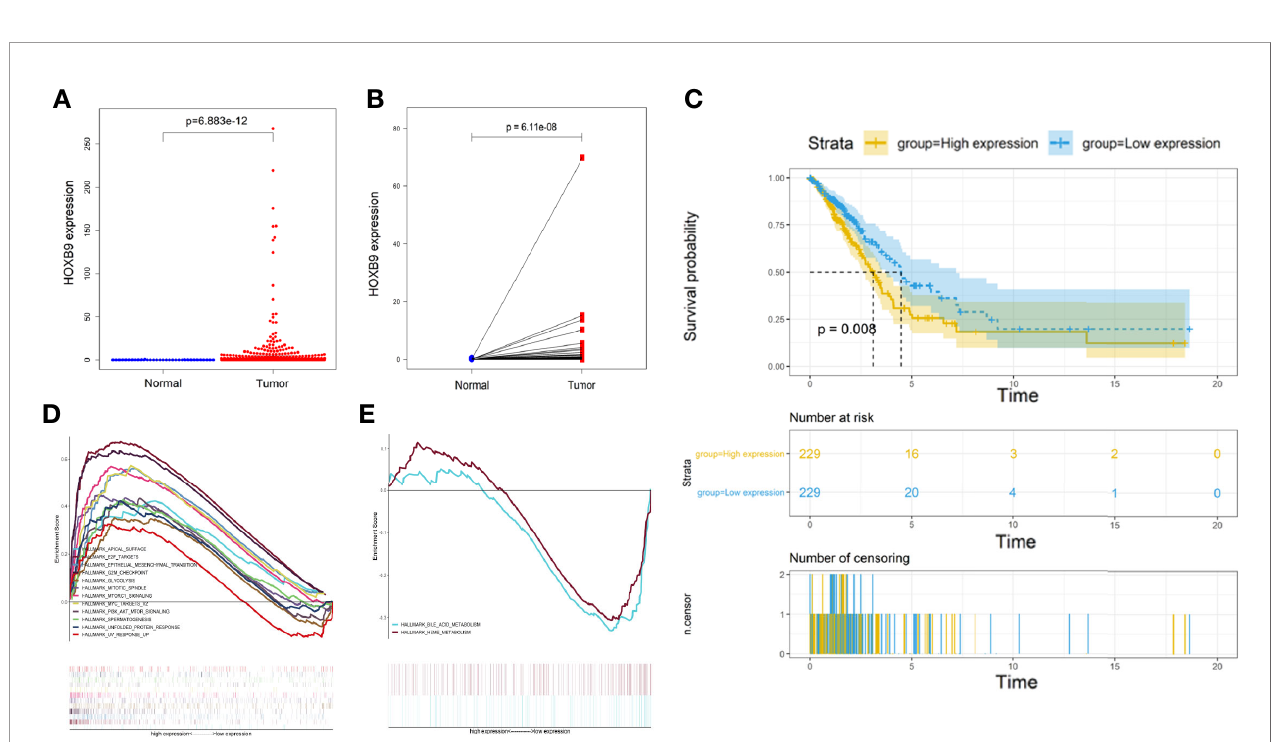
FIGURE 7 | Analysis of differential expression, survival, and GSEA of HOXB9. (A) The differential expression of HOXB9 between the overall normal and tumor tissues in the LUAD patients in TCGA database, p < 0.05. (B) The differential expression of HOXB9 between the normal and tumor tissues deriving from the same patient, p < 0.05. (C) Survival analysis of HOXB9 for the LUAD patients from TCGA database, p < 0.05. (D) The signi fi cantly enriched gene sets by the samples of HOXB9 upregulation in the GSEA. (E) Enriched gene sets by the samples with HOXB9 downregulation in the GSEA. Terms of the gene sets enriched with p -and q -values < 0.05 were considered signi fi cantly